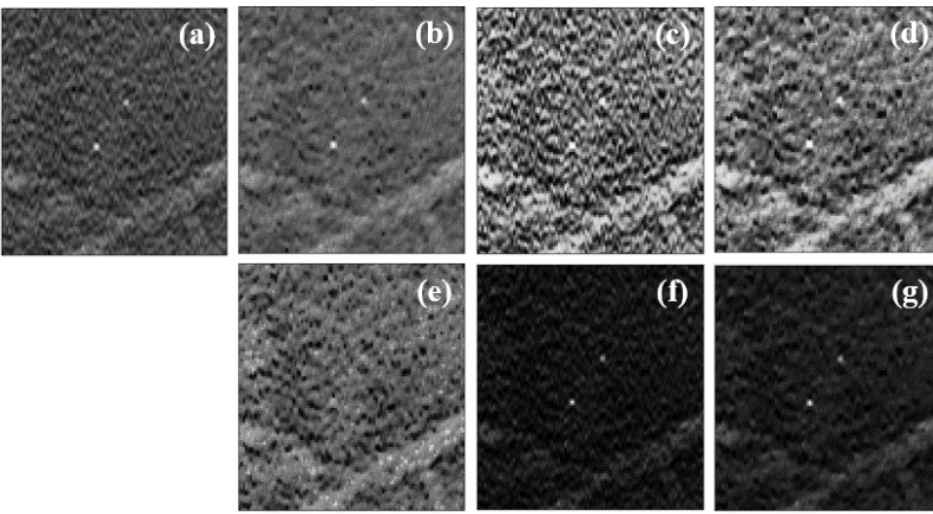
Figure 5. ( a ) Original data without preprocessing; ( b ) preprocessing 1 (minimization of TV); ( c ) preprocessing 2 (CLAHE); ( d ) preprocessing 3 (minTV + CLAHE); ( e ) preprocessing 4 (CLAHE + minTV); ( f ) preprocessing 5 (dataNorm2); ( g ) preprocessing 6 (dataNorm2 + minTV).